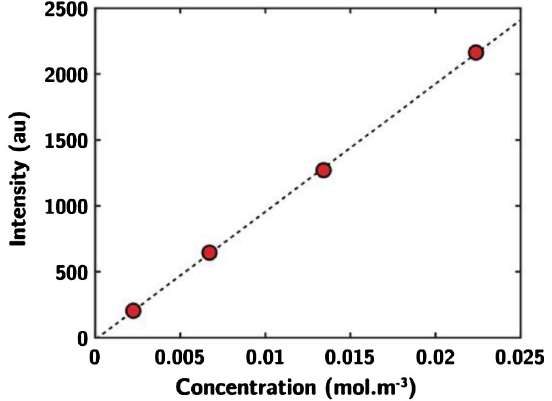
FIG. 6. Calibration of fluorescence intensity with mechano- phore concentration. Typical calibration curve, showing the linear relation between fluorescence intensity and concentration of calibration molecule.